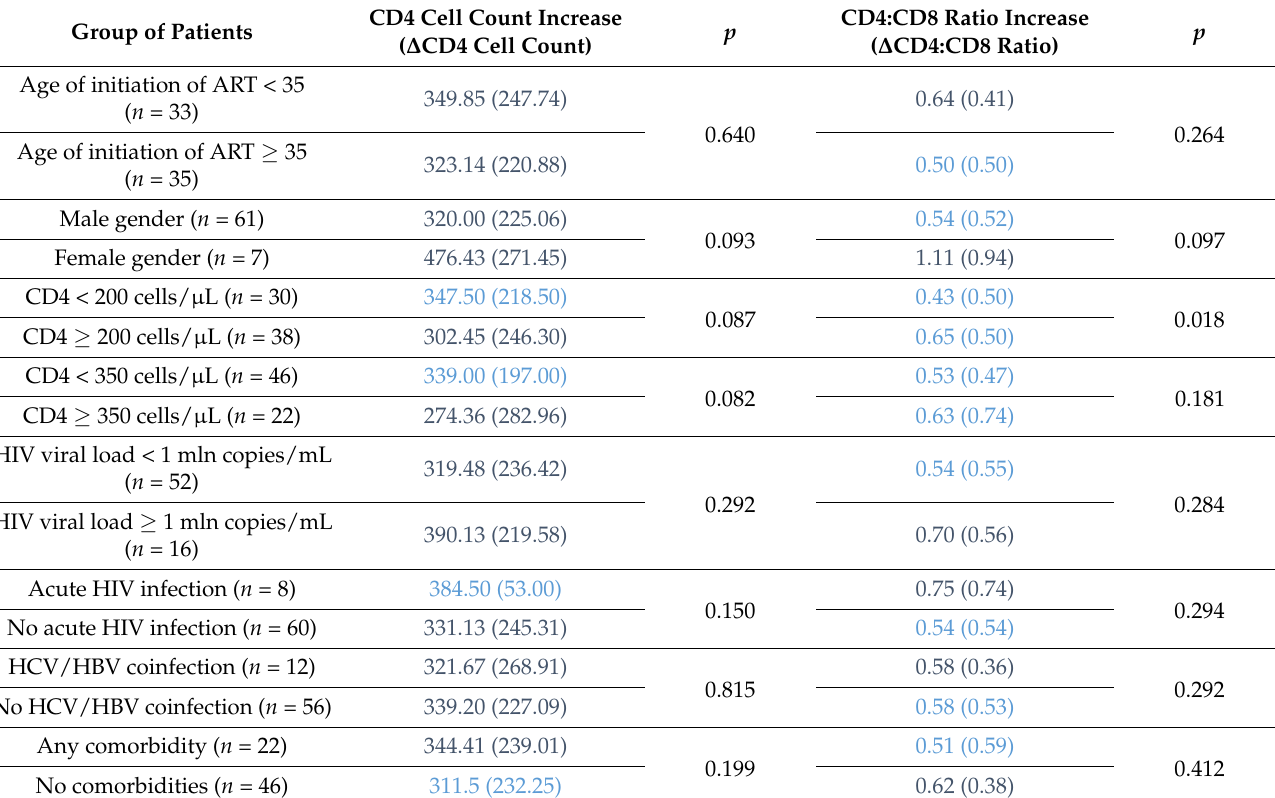
Table 3. CD4 cell count and CD4:CD8 ratio recovery depending on clinical biomarkers.